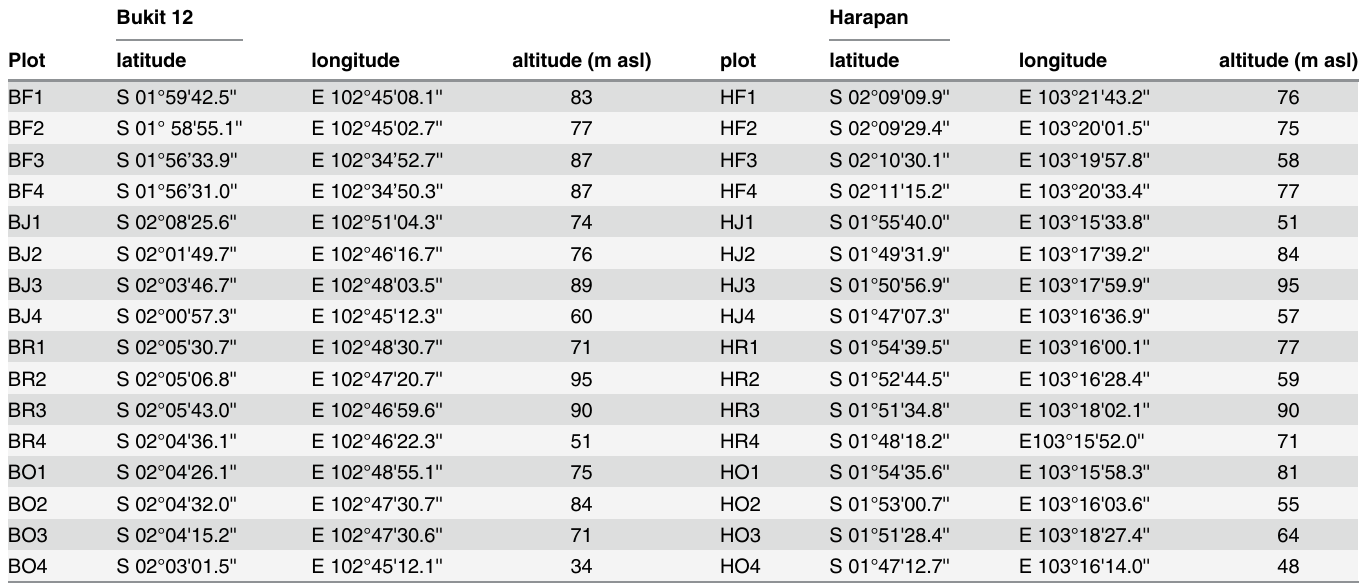
Table 1. Geographic location of the research plots in two landscapes and four forest types on Sumatra (Indonesia). Bukit 12 Harapan Plot latitude longitude altitude (m asl) plot